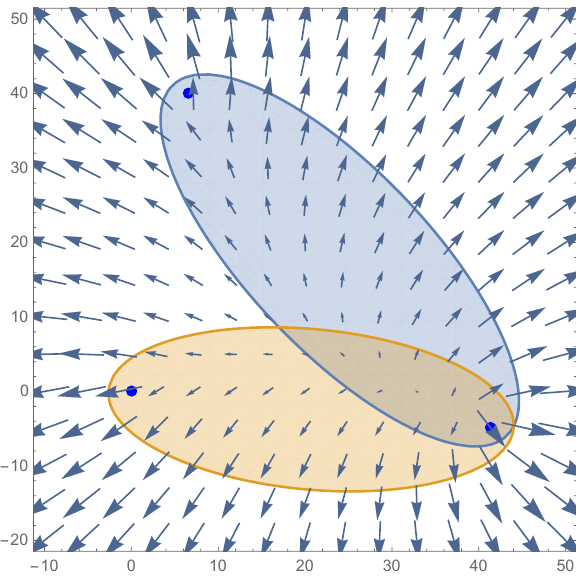
Figure 2. A correct deformation for two E-surfaces represented in the k by summing the normal vector (cid:12)elds of each of the two